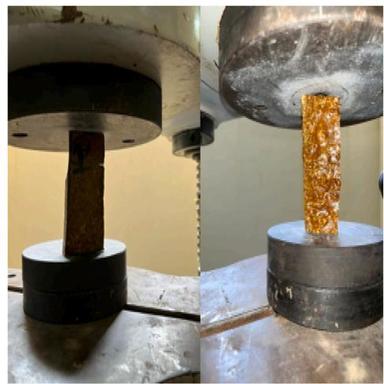
Compression test specimens of Citrus limetta peel powder fiber composite.